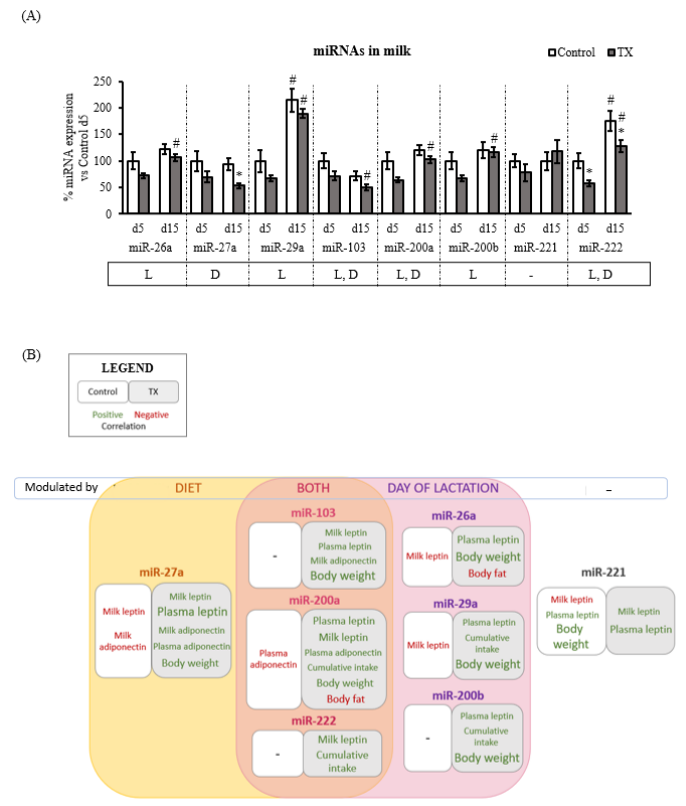
Figure 3. Levels in the milk of several miRNAs involved in leptin signalling in the control and TX groups at days 5 and 15 of lactation ( A ) and a schematic representation of the associations found between these miRNAs and milk leptin and adiponectin and other phenotypical variables ( B ). ( A ) Results are expressed relative to the miRNA expression values at day 5 of controls for each miRNA. Data are mean ± S.E.M. ( n = 7). ( B ) In yellow are the miRNAs exclusively modulated by maternal diet. Those that were modulated by the day of lactation are shown in purple, and those that were modulated by both factors are shown in pink. The correlations found in the control group are shown in the white boxes, whereas the ones observed in the TX dams are grouped in grey. If the variable is represented in green, it means a positive correlation; otherwise, it is represented in